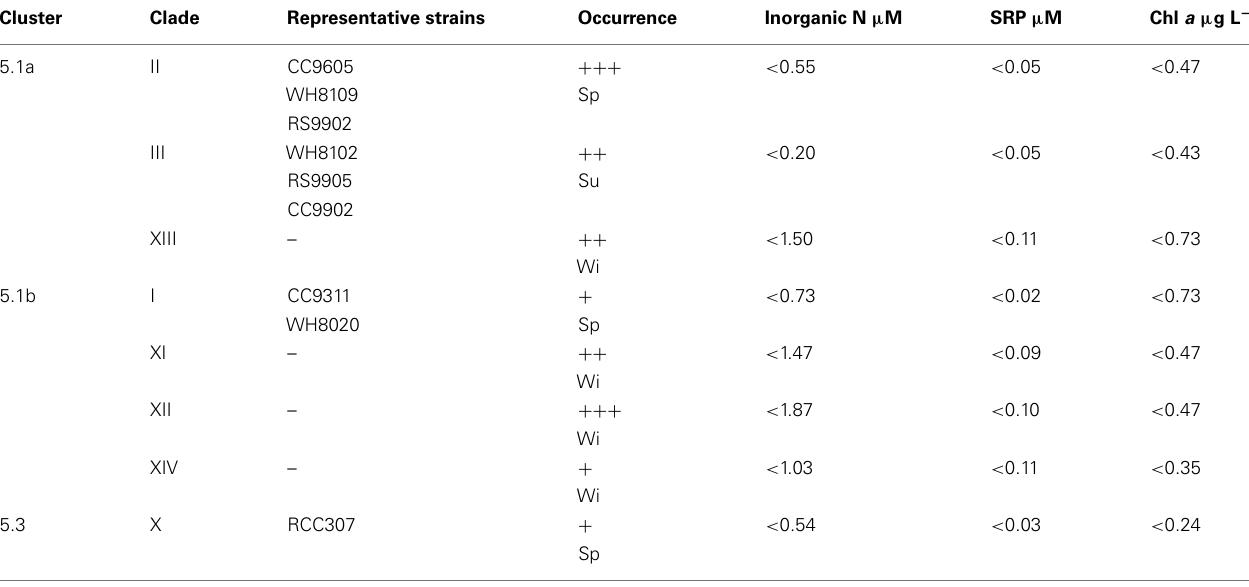
Table 2 | Representation of Synechococcus genotypes in ntcA clone libraries with + low, ++ intermediate, and +++ high frequency occurrence in their season of prevalence (Sp, spring; Su, summer;Wi, winter). Cluster Clade Representative